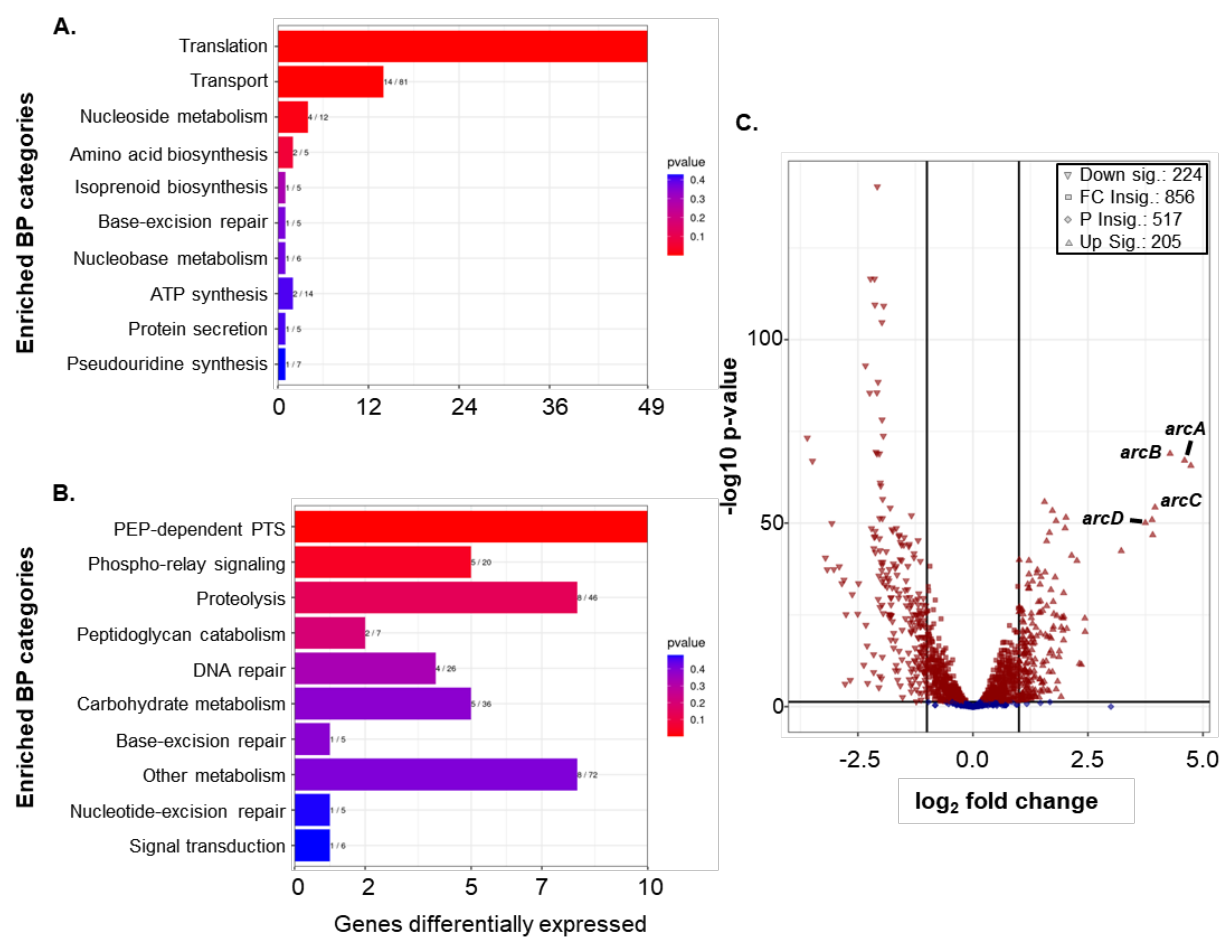
Figure 5. RNA-seq analysis of the rpoE mutant compared to WT 5448 in THY medium. Transcript levels were measured by RNA-seq for the rpoE mutant relative to the WT 5448 and ontology enrich- ments were analyzed. Genes that were upregulated ( A ) and those that were downregulated ( B ) were plotted based on biological purpose (BP) and in order of confidence based on their predicted BP using goseq software, with those groups most overrepresented being shown in red. ( C ) Volcano plot of RNA-seq DESeq2 analysis used to determine genes that were differentially expressed (log2) and p -value (log10). All genes greater than two-fold differential expression in the rpoE mutant vs. the WT are shown outside of the vertical black bars. Red symbols in the volcano plot represent genes that show a differential expression with a p -value < 0.05 whereas blue indicates those above that level.